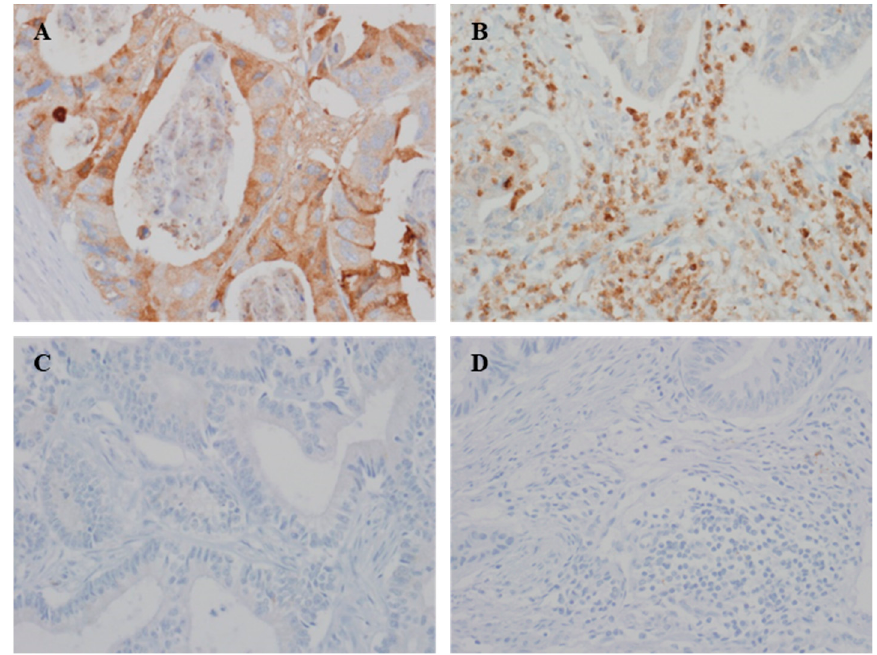
Figure 1. Representative immunohistochemical staining images of YKL-40. ( A , C ) Positive and negative YKL-40 expression in tumor cells. ( B , D ) Positive and negative YKL-40 expression in immune cells (×400). Table 1. Correlation between YKL-40 expression and clinicopathological parameters in colorectal cancers. YKL-40 Expression in Immune Cells p